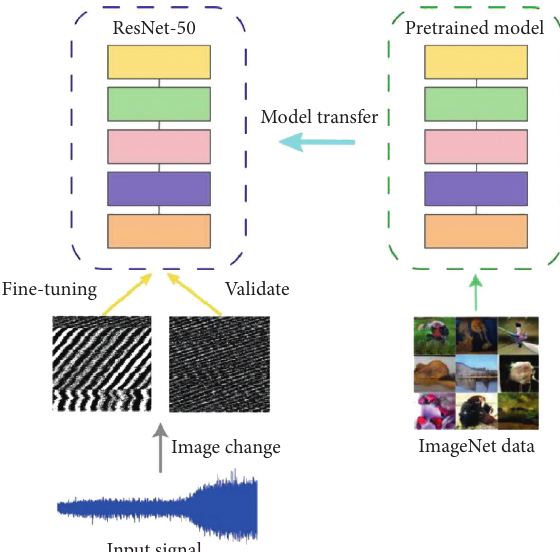
Figure 4: The process of transfer learning.